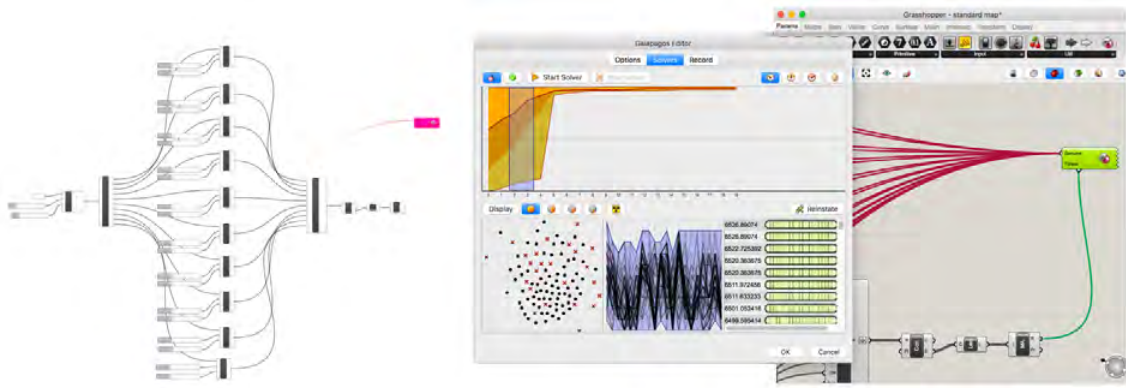
Figure 12. Solvers provided by Galapagos